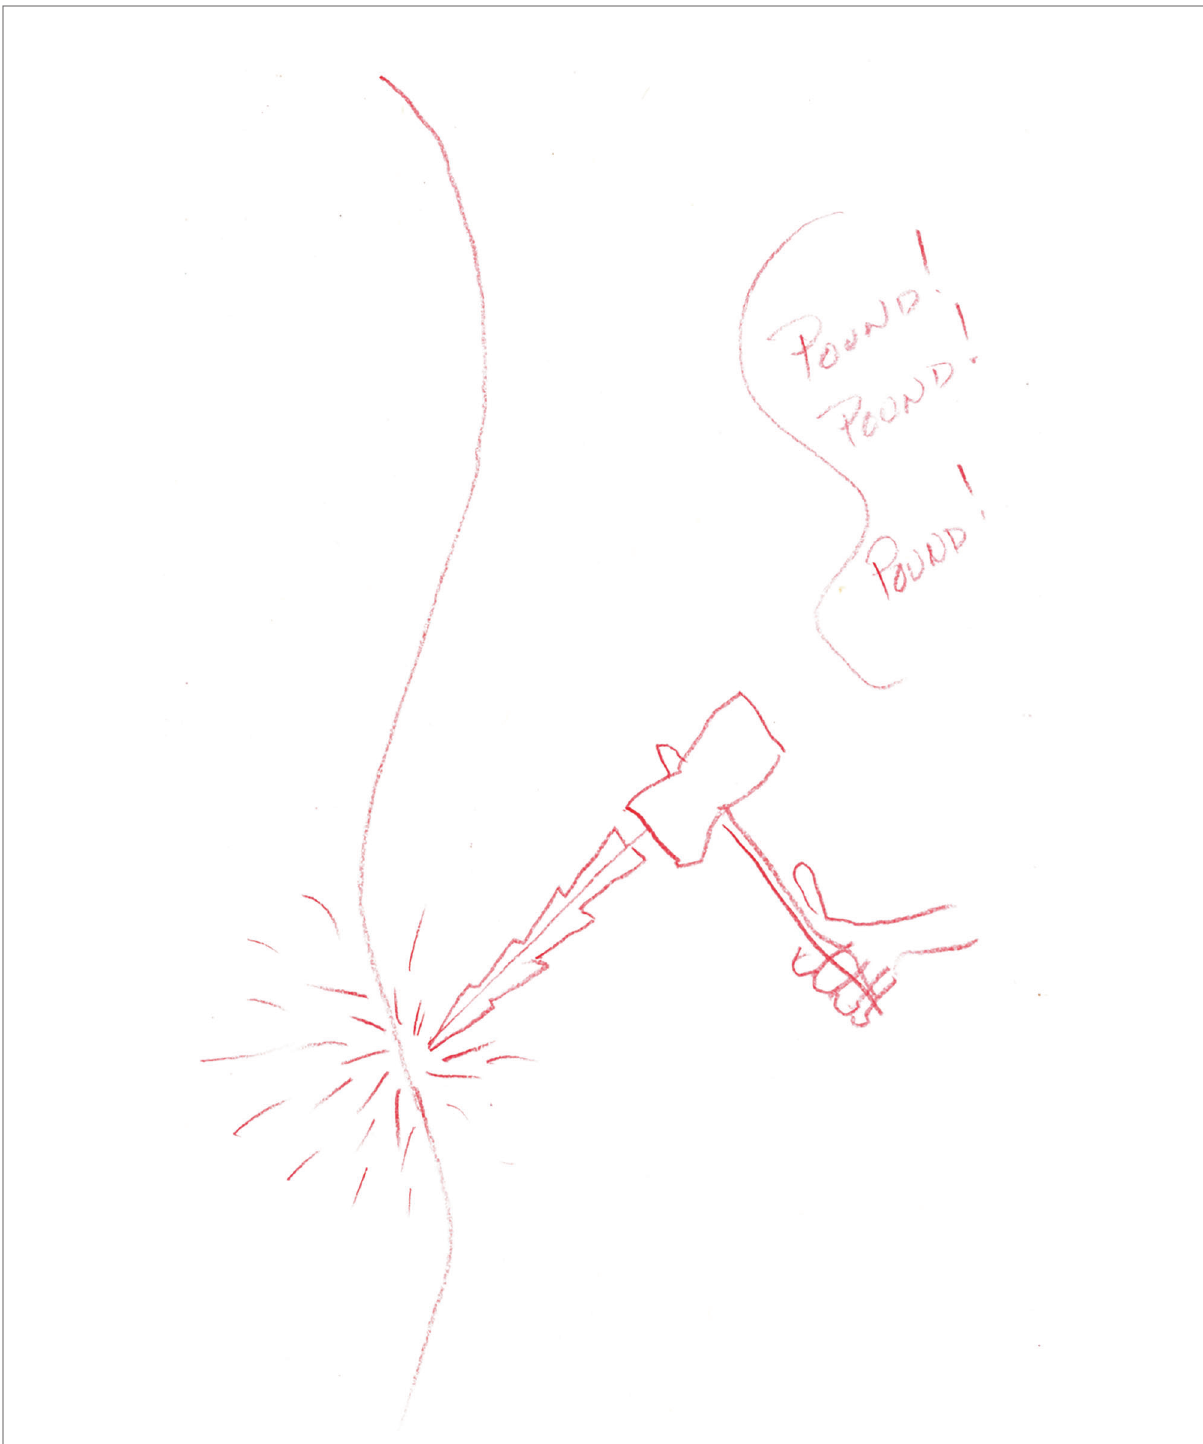
FIGURE 1 Pain as a red